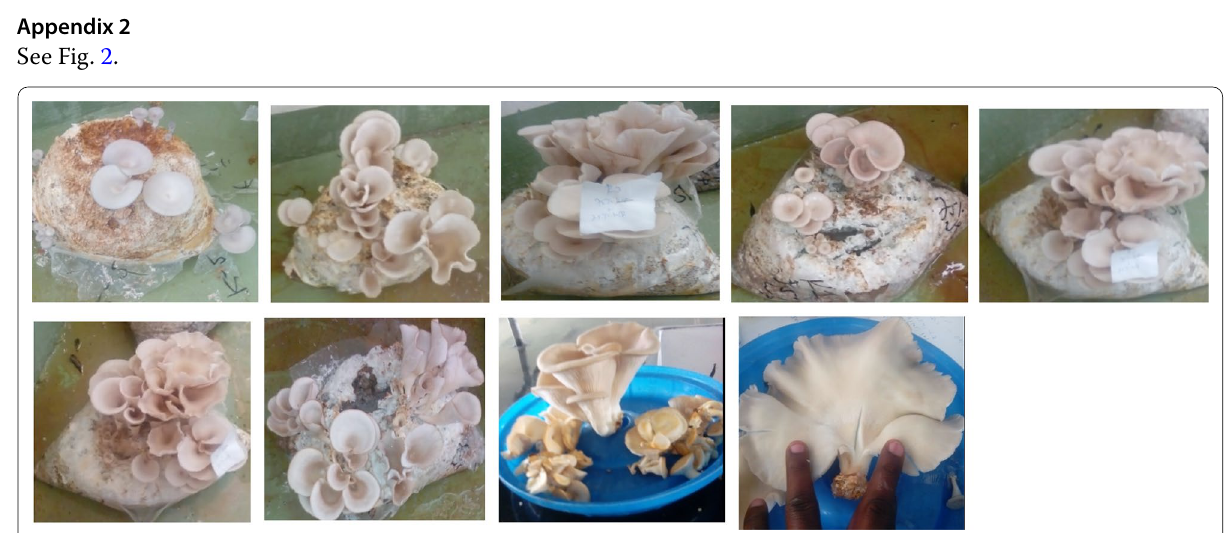
Appendix 2 See Fig.